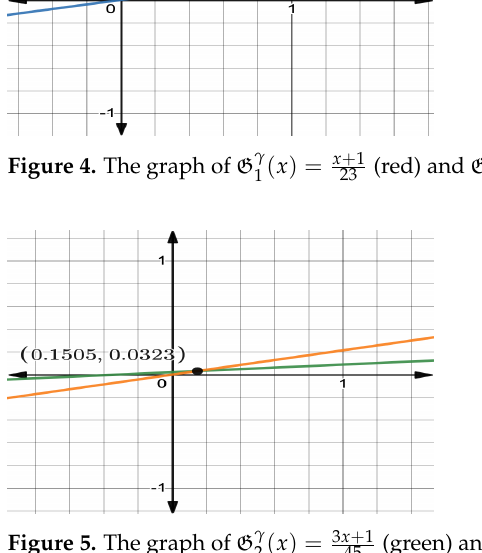
Figure 5. The graph of G γ